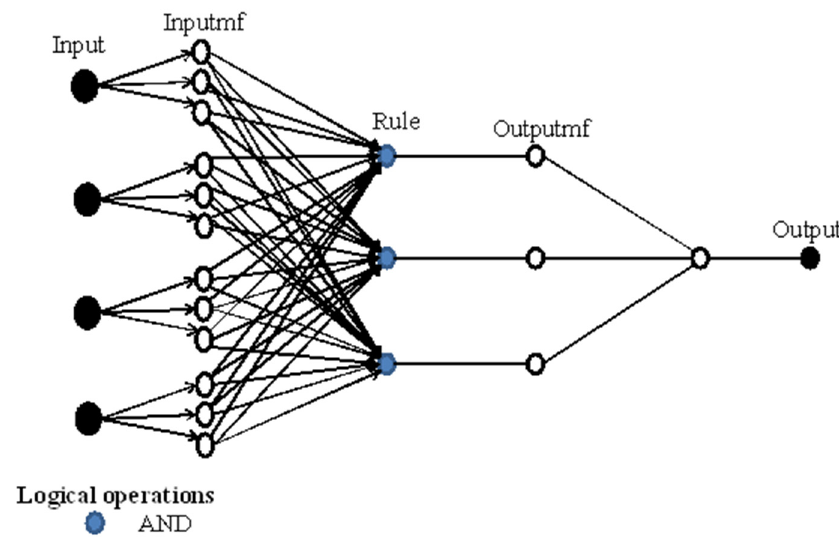
Figure 10. Proposed ANFIS model for thermal damage factor. Table 3. The properties of the proposed ANFIS model under both cooling conditions. Value (Thermal Damage Factor on Porosity and Elasticity) ANFIS Parameters Slow